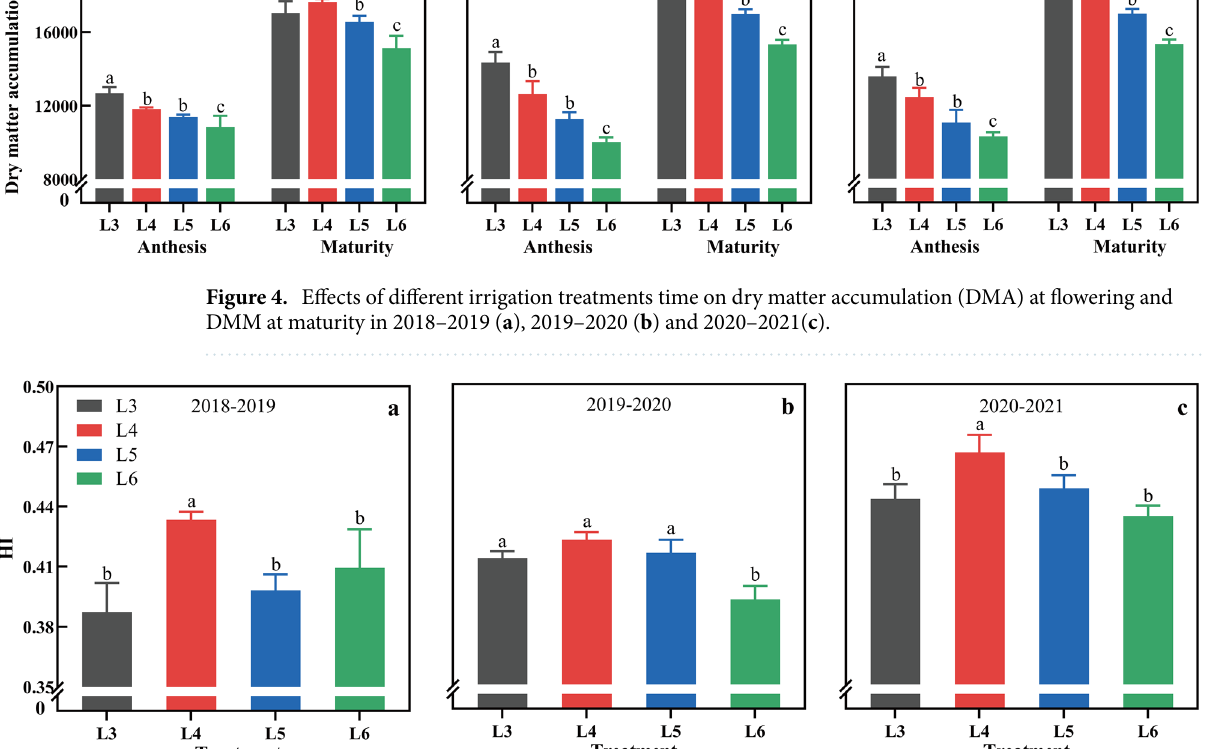
Figure 5. Effects of different irrigation treatments time on harvest index in 2018–2019 ( a ), 2019–2020 ( b ) and 2020–2021 ( c